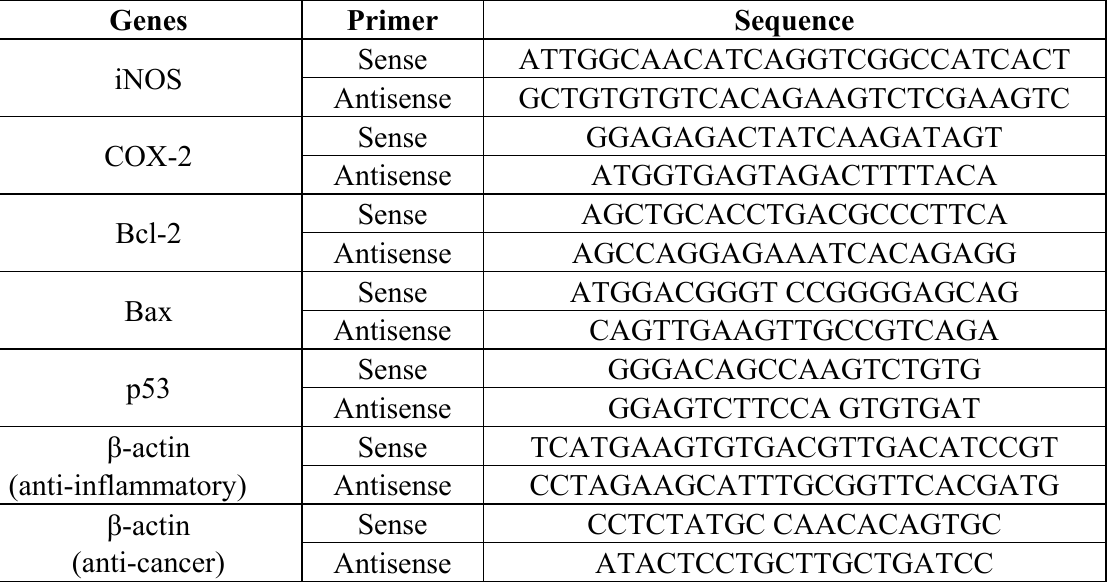
Table 1. Sequences of the primers used in RT-PCR